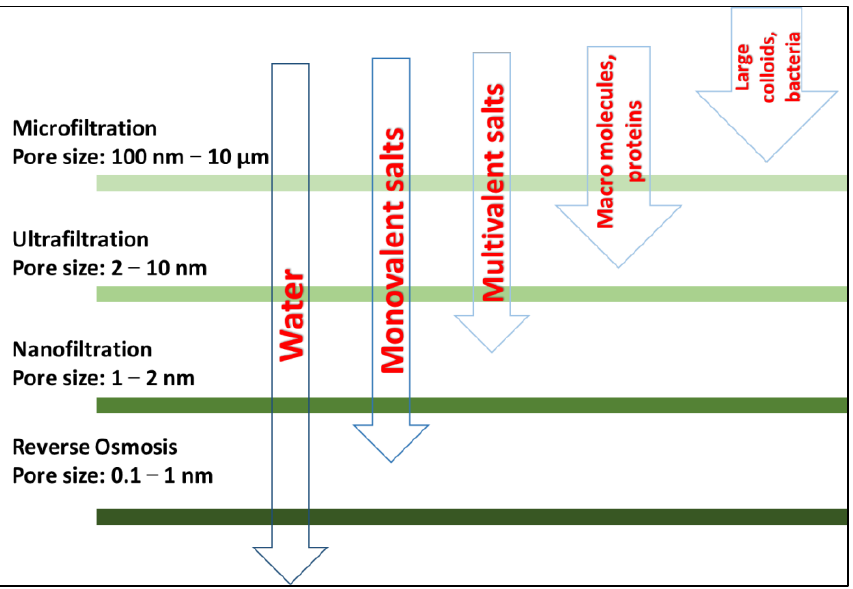
Figure 1. Type of pollutants removed by each class of membrane.